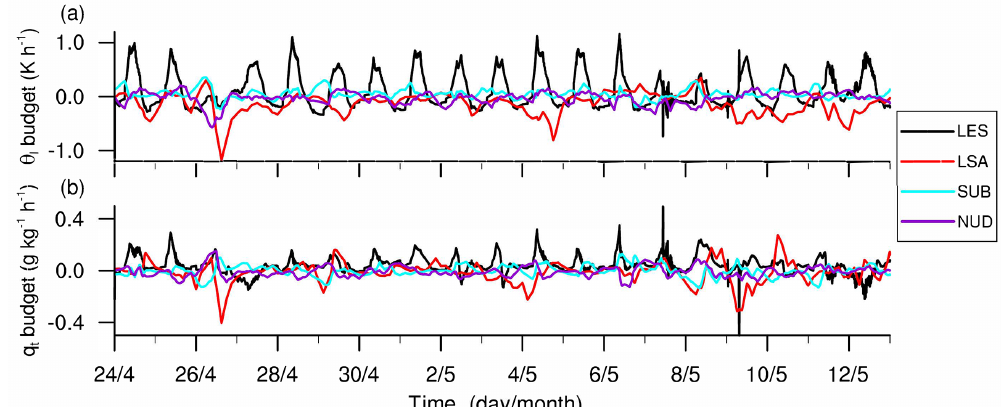
Figure 2. Temporal evolution of the vertically averaged budget terms of liquid water potential temperature (a) and total water mixing ratio (b) of case RP. The black lines (LES) show the sum of fast LES physics (advective, subgrid diffusive and microphysical) tendencies, the red lines (LSA) denote the tendencies due to larger-scale horizontal advection, the cyan lines (SUB) show the larger-scale subsidence tendencies and the violet lines (NUD) denote the nudging tendencies. The vertical average is taken between the surface and the depth of the boundary layer z i (in case z i < 500m, the upper limit for the averaging is